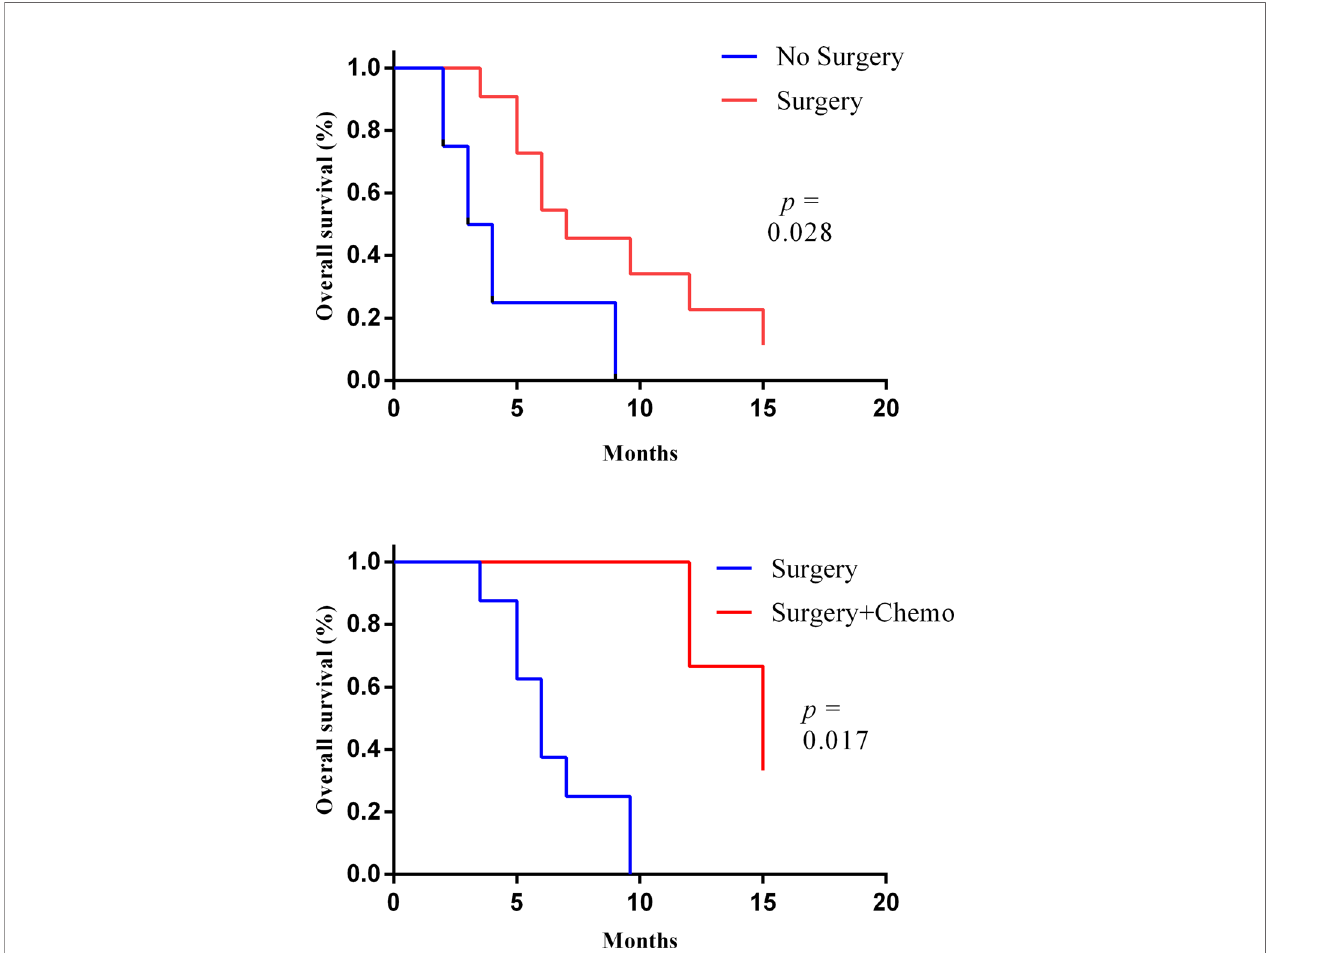
FIGURE 3 | The Kaplan – Meier curves of the overall survival of patient with or without surgery (upper) and with or without adjuvant chemotherapy after surgery